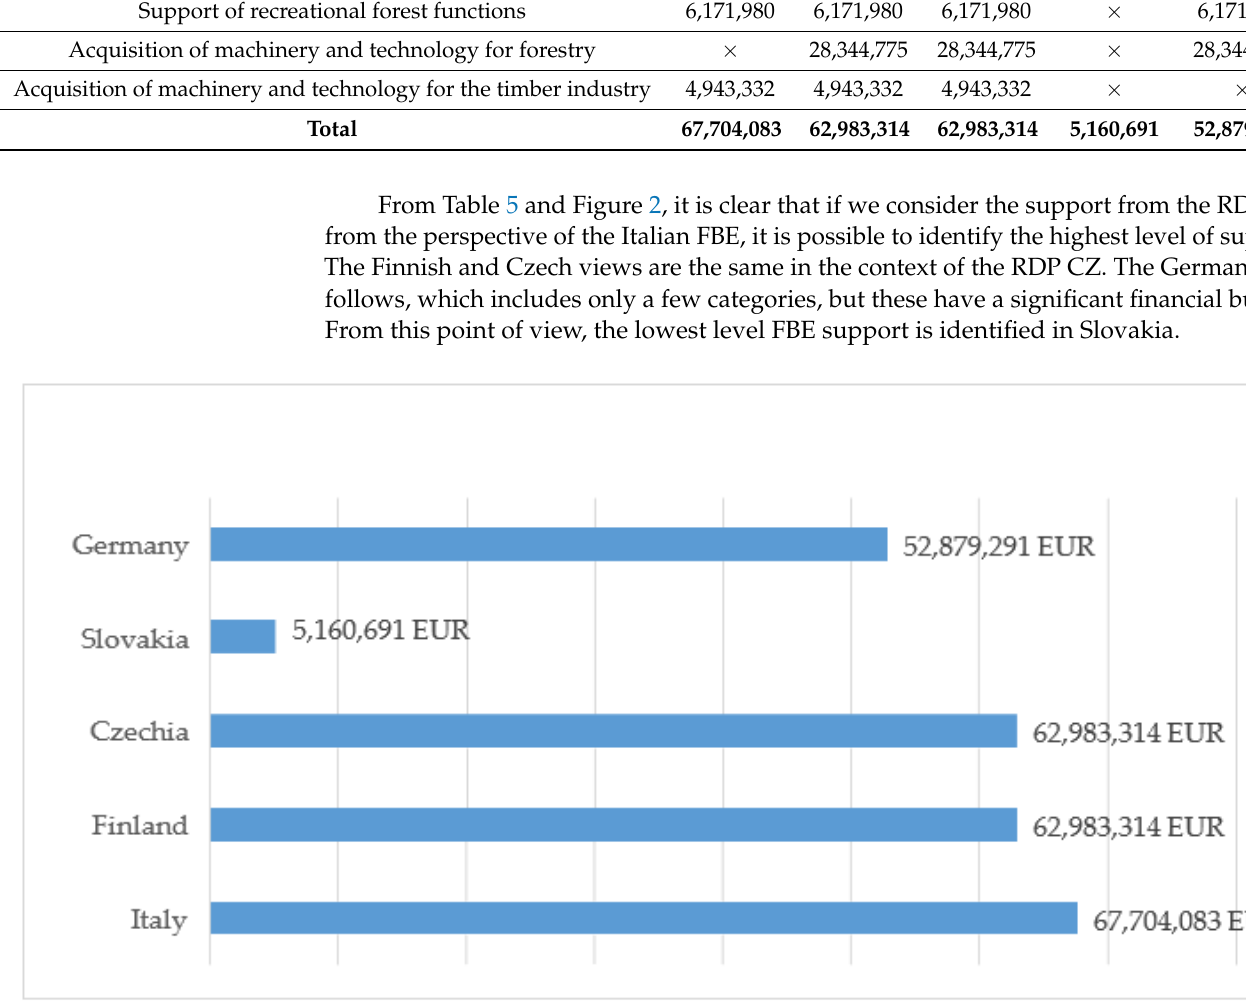
Figure 2. Financial support for the FBE in the RDP CZ from the point of view of the approaches of the researched countries